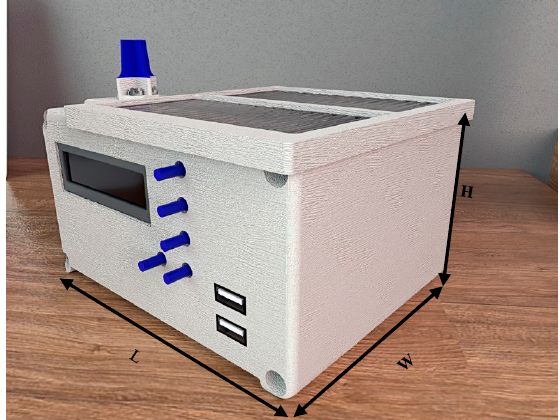
Figure 11. Proposed prototype for measurement of sunshine duration (SD).